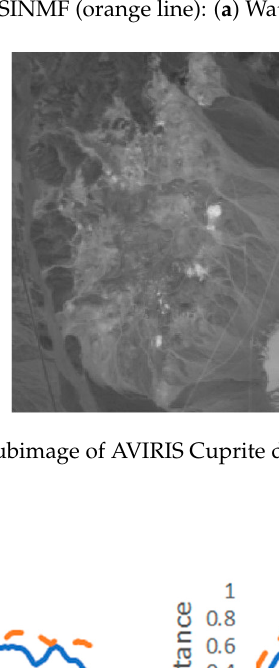
Table 10. SAD results on the AVIRIS Cuprite data.